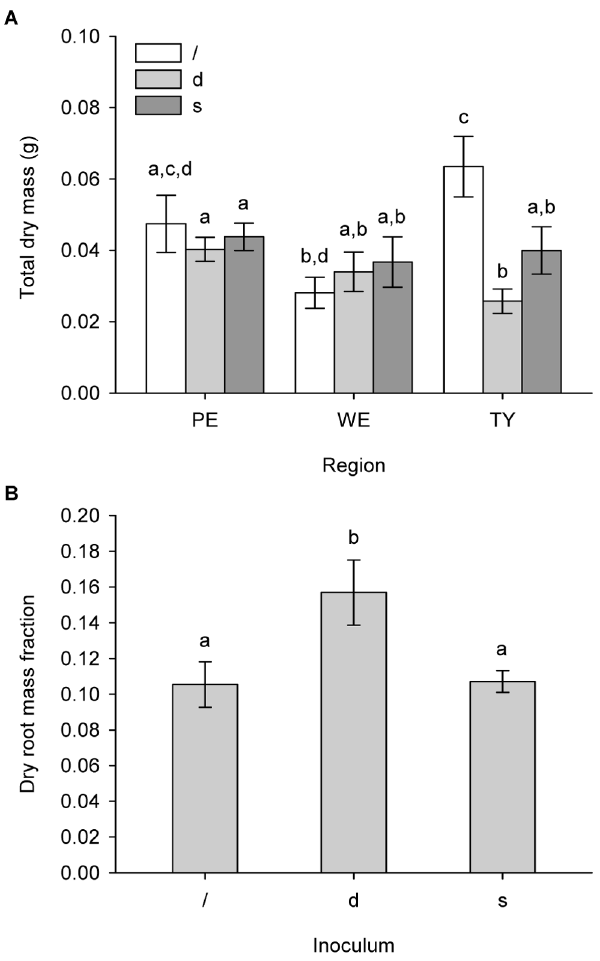
Figure 1. Effect of different soil treatments on characteristics of A. arenaria seedlings (mean + SE). A) Effect of region and soil inoculum on total dry mass of the plant. B) Effect of soil inoculum on the root fraction of the total plant dry mass. Significant pairwise differences are indicated by different letters above the bars ( P , 0.05). Region - PE: Le Perroquet, WE: Westhoek, TY: Ter Yde. Inoculum -/: no inoculum, d: dynamic dune biota, s: stabilised dune biota.